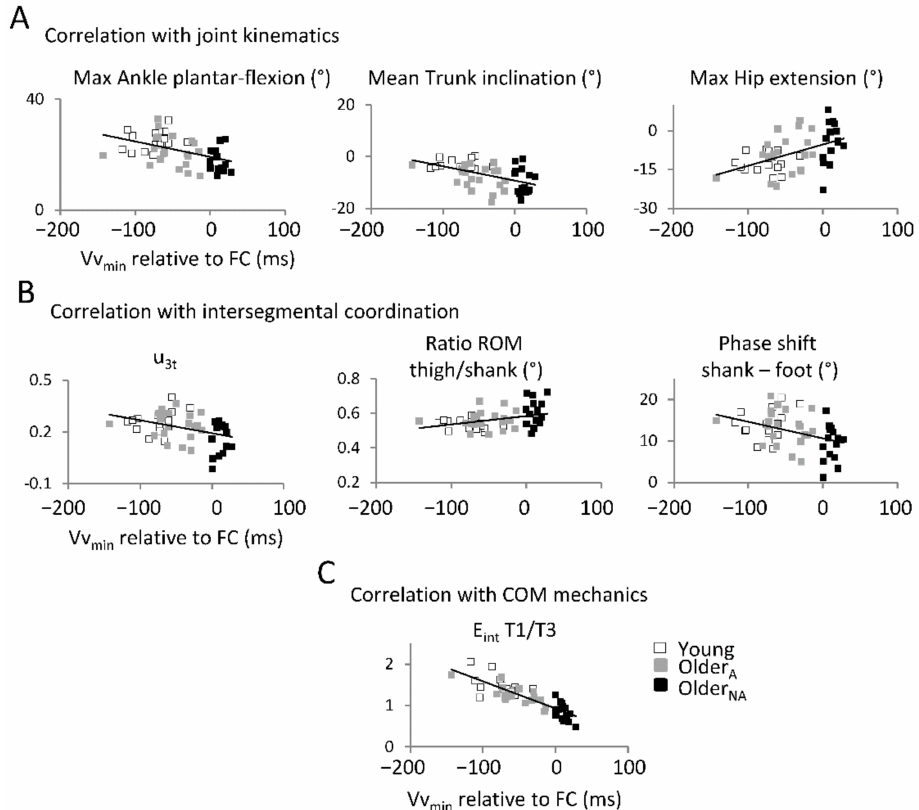
Figure 5. Correlations between step-to-step transition and other gait parameters. Each point rep- resents the stride-averaged value for one subject walking at 1.11 m s − 1 . Linear regression lines are also plotted. ( A ) Relationships between the delay between the minimal vertical velocity of the COM (Vv min ) and foot contact (FC) and joint kinematics: maximal ankle plantar-flexion, mean trunk orientation and maximal hip extension. ( B ) Relationships between the delay between Vv min and FC and intersegmental coordination: orientation of the plane ( u 3t ), ratio between the range of motion of thigh and shank segments and the phase shift between shank and foot segments. ( C ) Relationships between the delay between Vv min and FC and the ratio between E int measured during T1 and T3. Other indications as in Figure